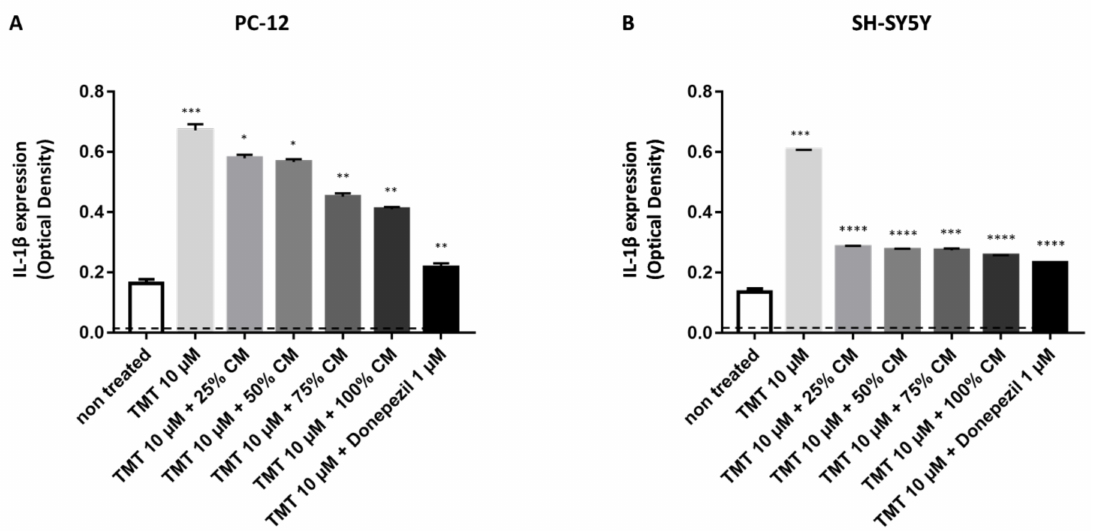
Figure 3. BUVEC-CM inhibits proinflammatory cytokine IL-1 β production after treatment with the neurotoxic agent TMT. To induce IL-1 β expression, ( A ) rat pheochromocytoma PC12 and ( B ) human neuron-like SH-SY5Y cell lines were preincubated with 10 µ M TMT or equimolar TMT + BUVEC-CM (0%, 25%, 50%, 75%, and 100%) diluted in the respective cell line media. Untreated cells were used as a negative control. The analgesic agent donepezil was used as a specific IL-1 β inhibitor induced by TMT. A dose-dependent reduction in IL-1 β concentration was observed with cytoplasmic lysate from the PC12 and SH-SY5Y cells treated with TMT and increased BUVEC-CM concentration. A constant reduction in IL-1 β concentration was observed in the SH-SY5Y cells treated with TMT and increased BUVEC-CM concentration. Data are presented as optical density (OD) proportional to IL-1 β concentration. A high OD represents high IL-1 β production. * p < 0.01, ** p < 0.001, *** p < 0.0001, **** p < 0.00001 against untreated